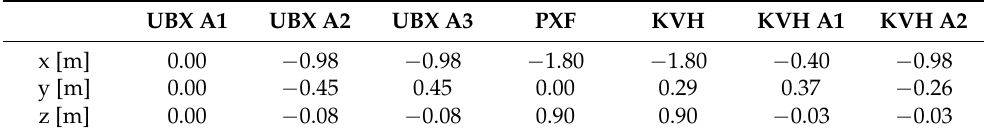
Figure 4. Measurement setup. Table 1. Lever arms between the applied sensors in